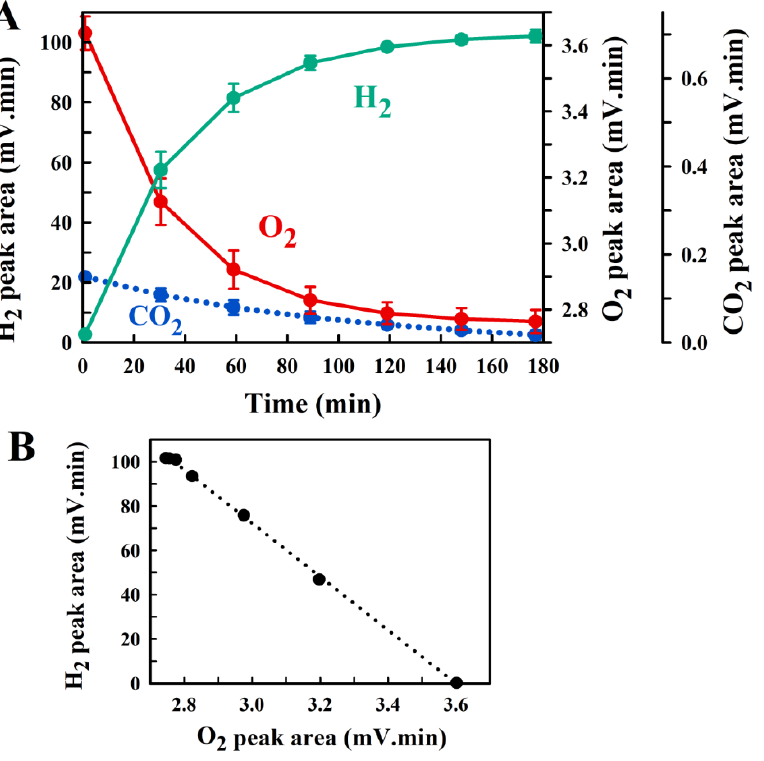
Figure 3. ( A ) The measured peak areas of the GC-chromatogram obtained in the NaBH 4 -H 2 evolution experiment. Average values and the respective standard deviations (error bars) from four different experiments are shown. The zero time point refers to the time after addition of the NaBH 4 pellet to water. The reaction is essentially complete after 150 min. The plateaus for H 2 and O 2 confirm the expectation that their reaction at room temperature is negligible for the time of the experiment. In ( B ) the linear correlation between increase of the H 2 peak area and decrease of the O 2 peak area is